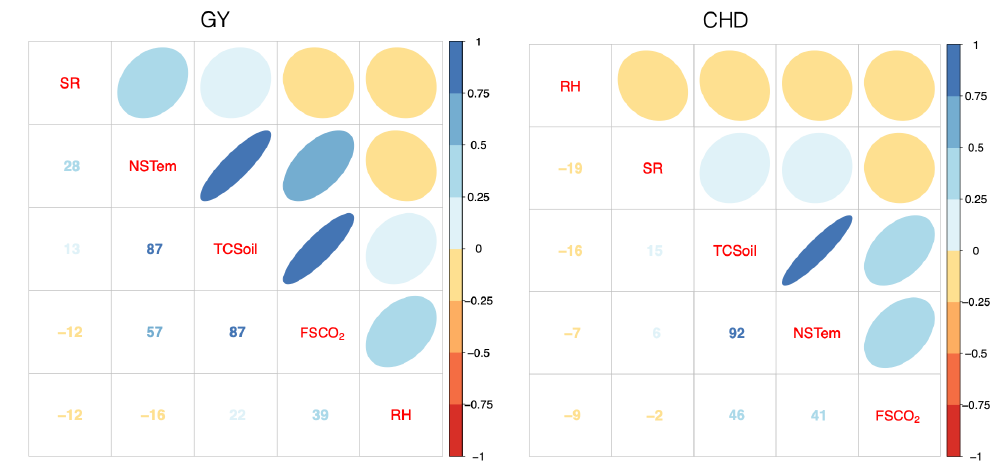
Figure 10. Relationship between the predicted FSCO 2 (PFCO 2 ) and environmental variables . GY re- fers to the GY site; CHD refers to the CHD site. refers to the GY site; CHD refers to the CHD